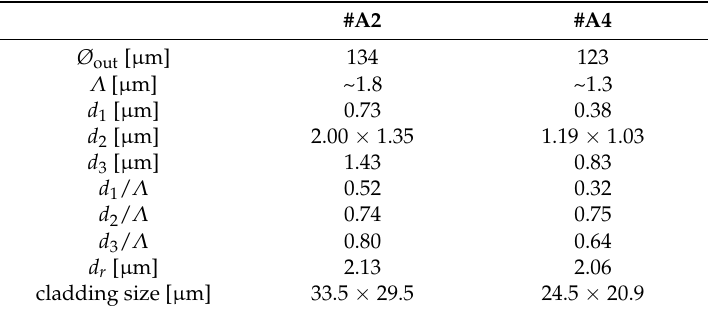
Table 4. Geometrical parameters of the selected developed PCFs.